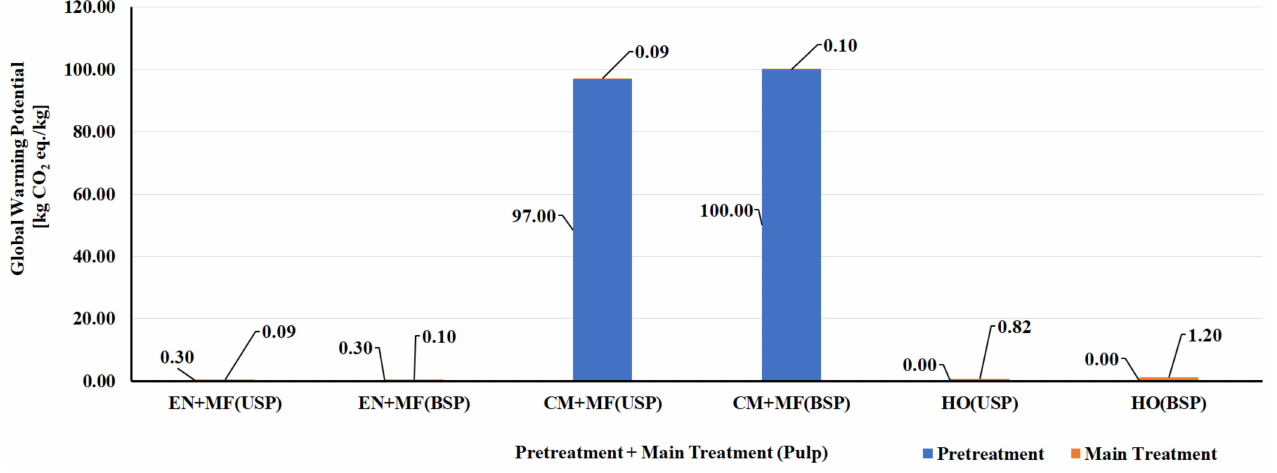
Figure 6. Global warming potential (GWP) of different pretreatment and main treatment processes of